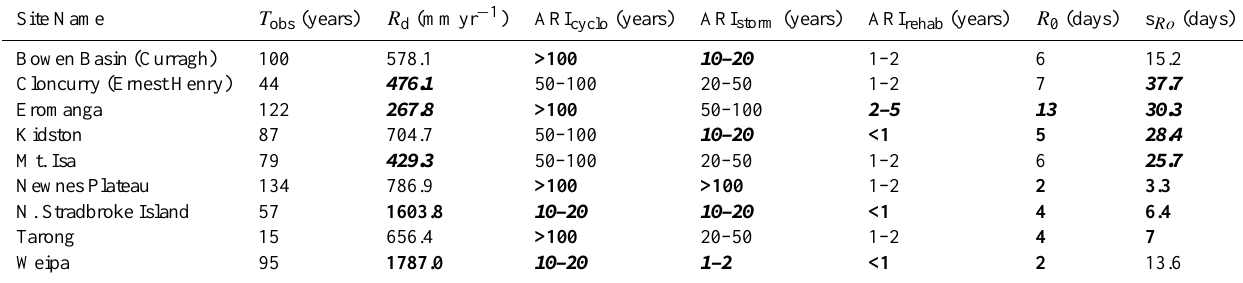
Table 3. Site-specific values of long-term rainfall